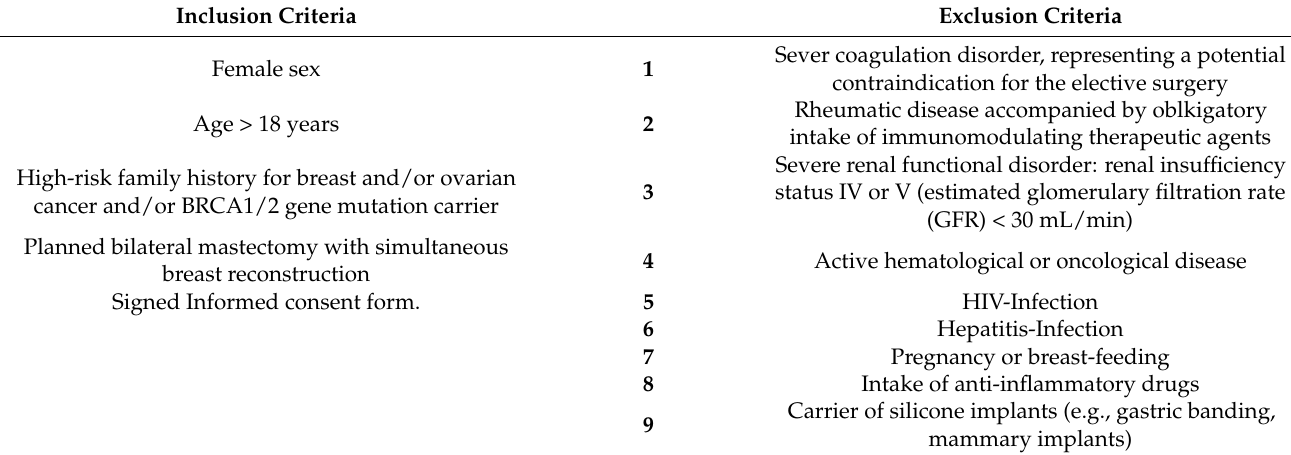
Table 1. Inclusion and exclusion criteria for the Expander-Immunology